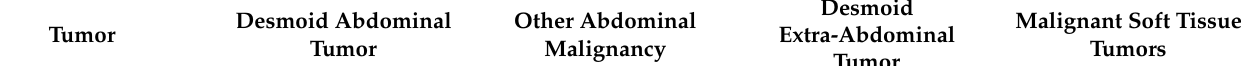
Table 2. Imaging features of abdominal and extra-abdominal DTs compared to other malignancies.